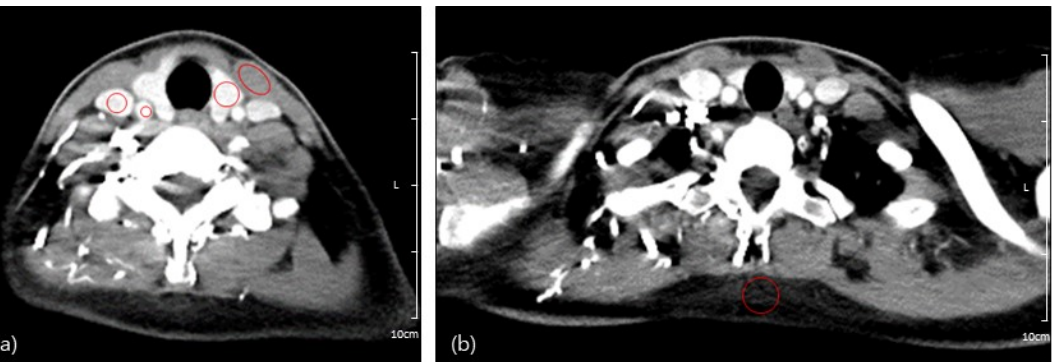
of interest in the thyroid gland, sternocleidomastoid muscle (SCM), internal jugular vein (IJV), com-